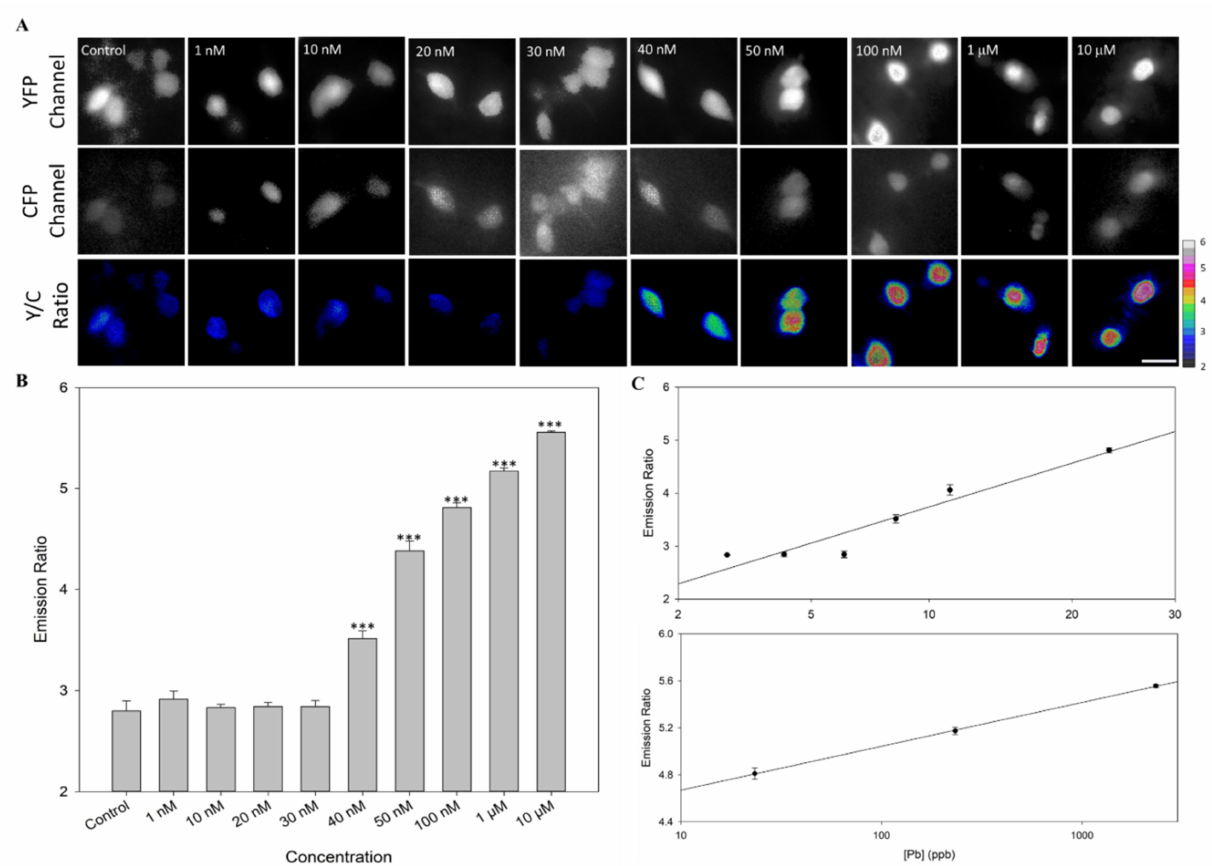
Figure 4. Sensing ability of pMet-lead. ( A ) The representative pMet-lead FRET ratio images of HEK293 cells expressing Met-lead 1.44 M1 taken at various concentrations of Pb from nM (1, 10, 20, 30, 40, 50, and 100 nM) to µ M ranges (1 and 10 µ M). The fluorescence images of Met-lead 1.44 M1 in the YFP and CFP channels, and the ratio color images (through the preprocessing procedure described in Figure 3) under CFP-specific illumination (405 nm). ( B ) Bar graphs of FRET ratios at various concentrations of Pb using pMet-lead analysis. The mean differences are described as significant at the 0.0005 (***) level. ( C ) Validation of pMet-lead (Y/C emission ratio) using ICP-MS (Pb measured in ppb) at various concentrations of Pb (upper: 10, 20, 30, 40, 50, and 100 nM; lower: 100 nM, 1 µ M, and 10 µ M). Scale bar, 30 µ m. The ratio color bar is from 2 to